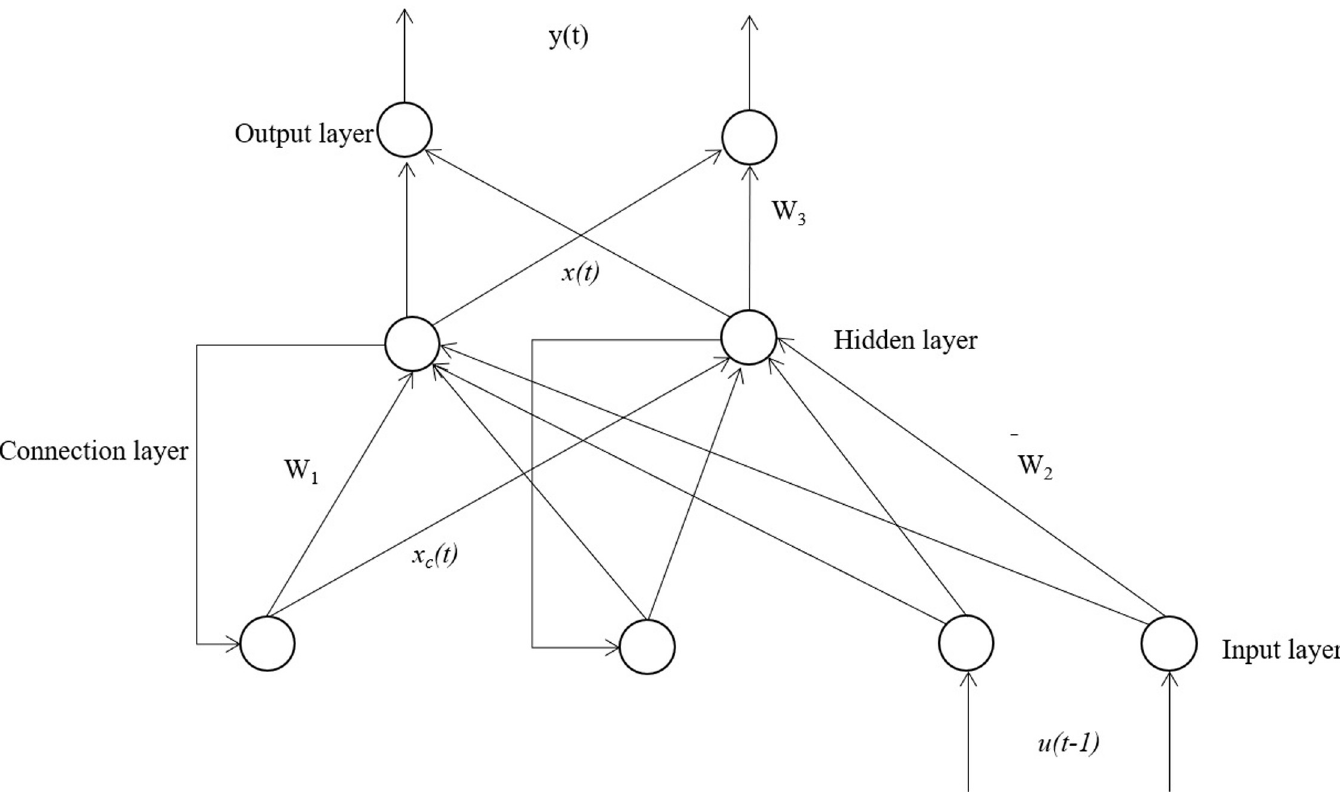
Fig 1. Structure diagram of Elman neural network.